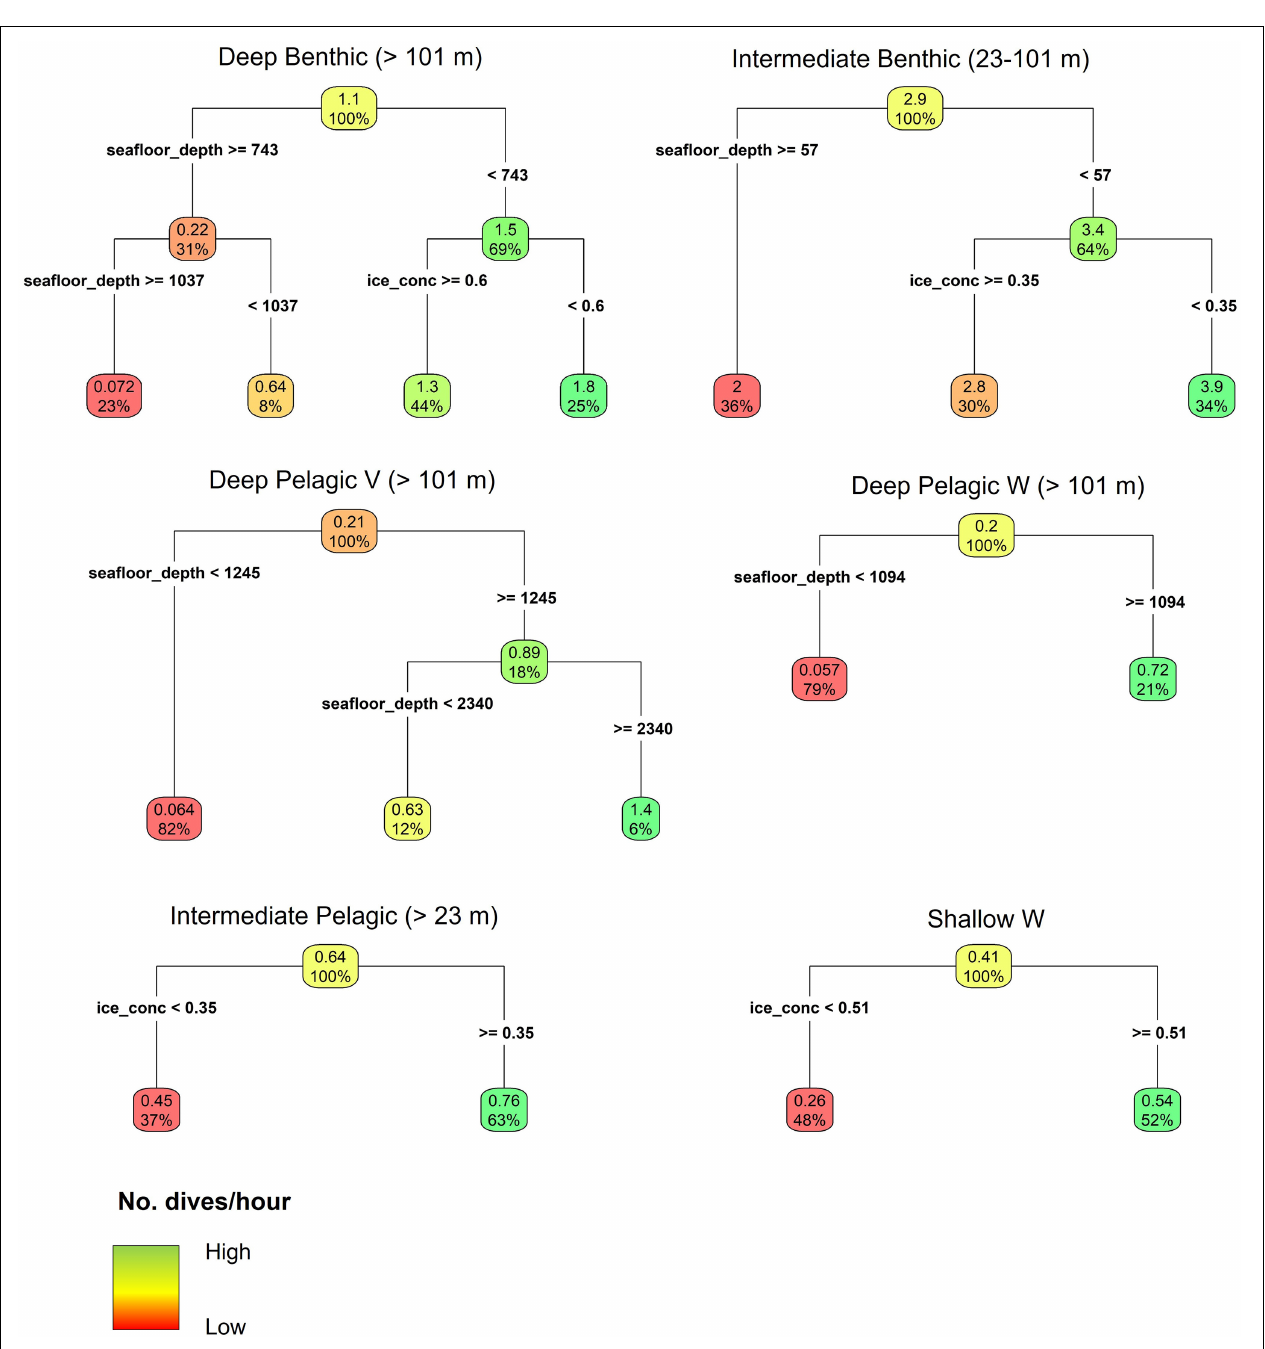
FIGURE 7 | Regression tree models for the hourly frequency of each dive type in relation to seafloor depth (seafloor_depth), sea ice concentration (ice_conc), and slope angle. Note that the model for the Shallow V dive type is not shown as regression trees identified no relationship between dive frequency and environmental parameters. The Deep Pelagic Skew dive type was not modeled due to low sample size. Parentheses next to the dive type show the range of seafloor depths over which the given dive type was modeled, due to prior discrimination in depth limits of certain dive types during the classification. The upper number in each node and leaf denotes the mean number of dives per hour given the environmental conditions above. The percentage in each node and leaf gives the proportion of the total number of observations conforming to the environmental conditions above. Sea ice concentration is the proportion of each 25 km 2 grid cell covered by ice.